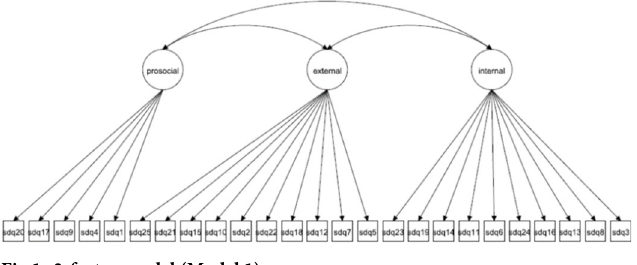
Fig 1. 3-factor model (Model 1).